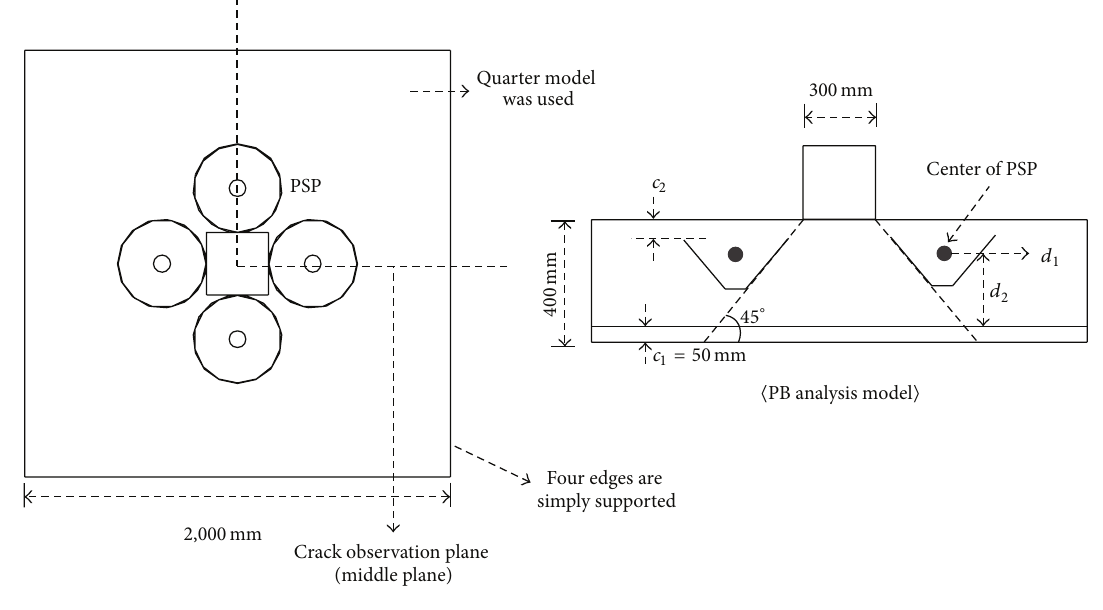
Figure 16: Dimensions of model for parametric study.